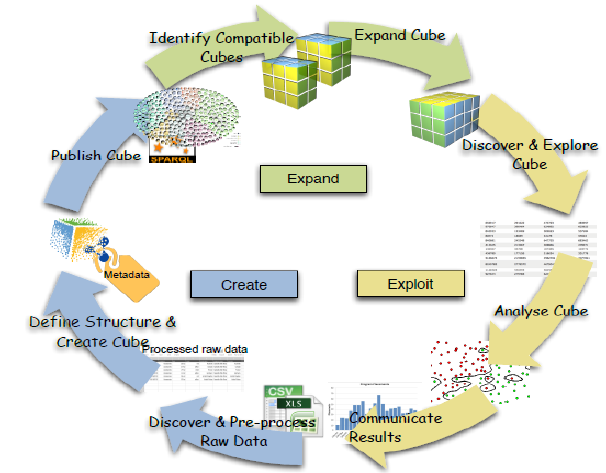
Figure 10: Statistical Open Data Process (from E. Tambouris et al.,